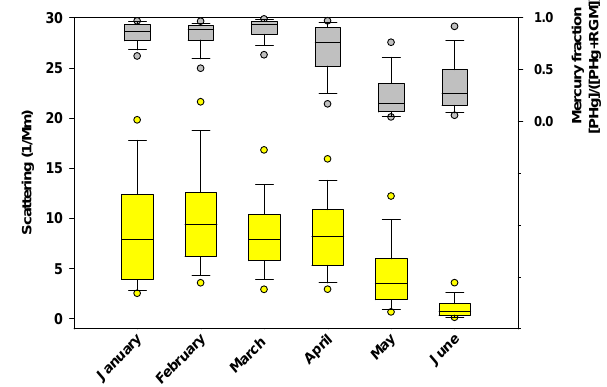
Figure 5: Monthly box and whisker plot of scattering (b sca ) and mercury fraction data from Alert. Nephelometer data is in (Mm-1) for 550nm (yellow) from January to June 2004 to 2009. Mercury fraction data is unitless and is from January to June 2002 to 2011. Centre line in the box represents the median value, the boundaries of the box represent the 25 th and 75 th percentiles, the whiskers represent the 10 th and 90 th percentile and the dots represent the 5 th and 95 th percentile.